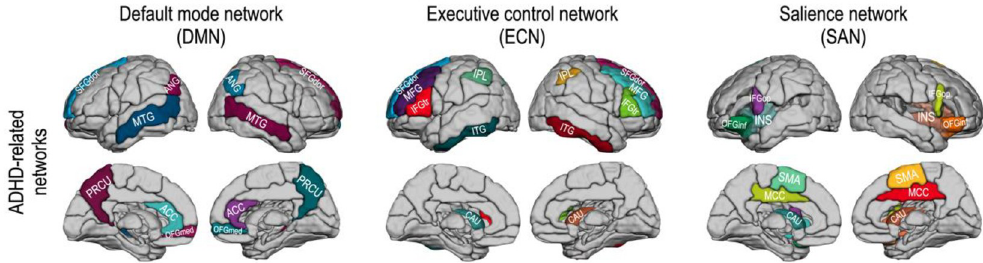
Fig 1. ADHD-related brain networks for subnetwork analysis—The default mode network (12 regions), executive control network (12 regions), and salience network (12 regions). Abbreviations: ANG, angular gyrus; PRCU, precuneus; ACC, anterior cingulate cortex; MCC, middle cingulate cortex; OFGmed, orbitofrontal cortex (medial part); MTG, middle temporal gyrus; SFGdor, superior frontal gyrus (dorsal part); MFG, middle frontal gyrus; IFGop, inferior frontal gyrus (pars orbitalis); IFGtr, inferior frontal gyrus (triangular part); IPL, inferior parietal lobe; CAU, caudate; INS, insular; MTG, middle temporal gyrus; ITG, inferior temporal gyrus; SMA, supplementary motor area.